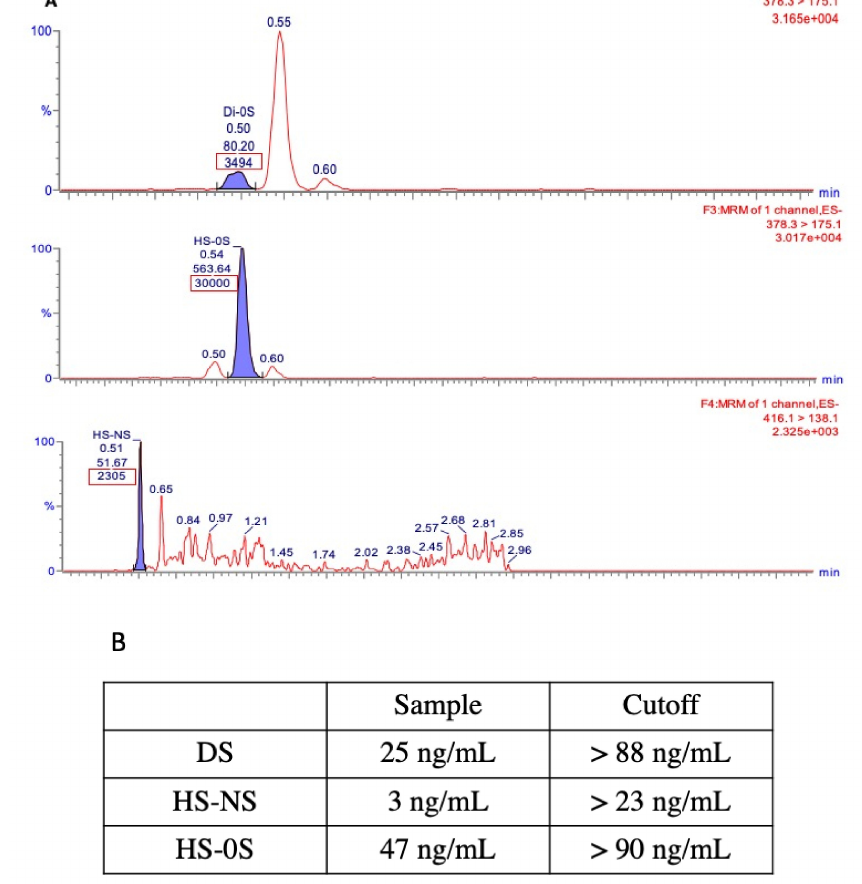
Figure 2. GAG levels in the screen positive sample for IDUA by LC / MS / MS. ( A ) Peak areas (red boxes) of dermatan sulfate (DS), heparan sulfate-0S (HS–0S), and heparan sulfate-NS (HS–NS), respectively. ( B ) GAG quantification in the screened positive sample for IDUA compared to the cuto ff for the newborn MPS I